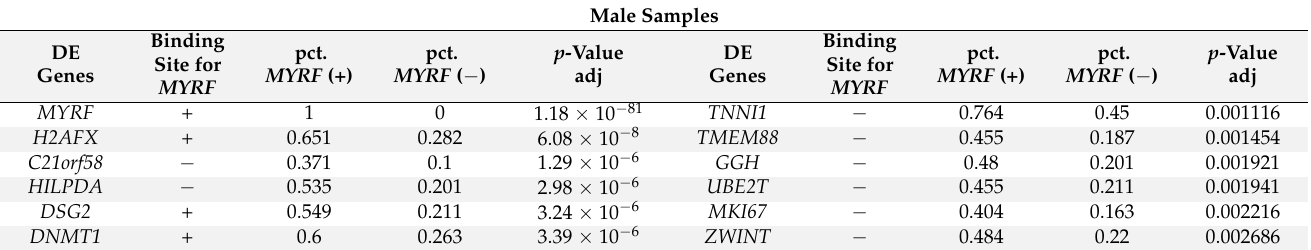
Table 2. List of genes differentially expressed between the cells that express MYRF and those that do not, in the coelomic epithelium cluster of